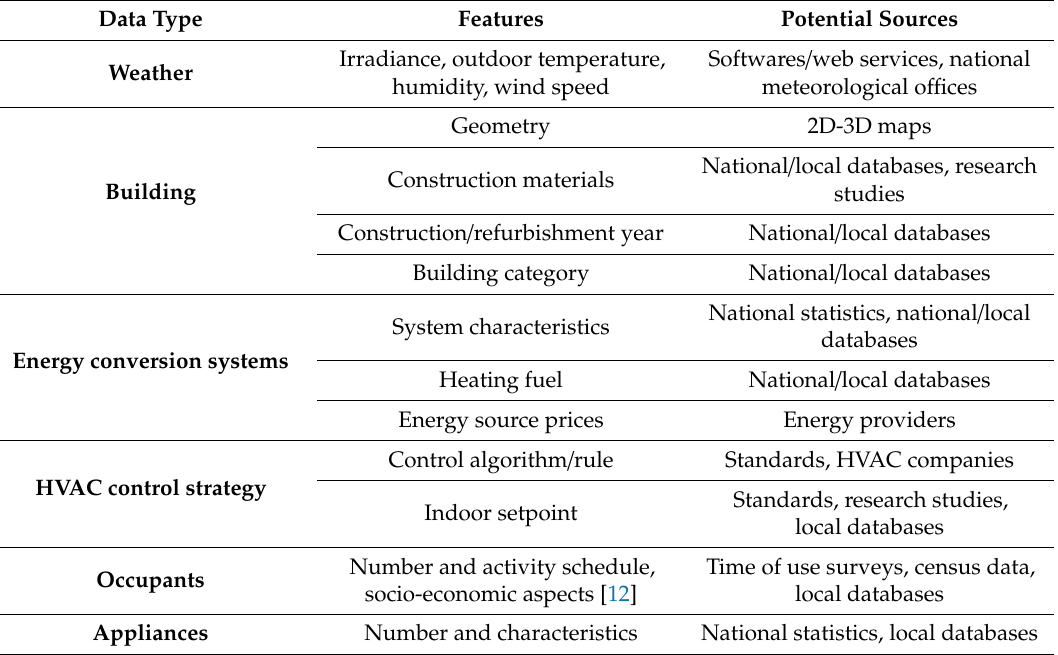
Table 1. Dataset and potential sources for building energy